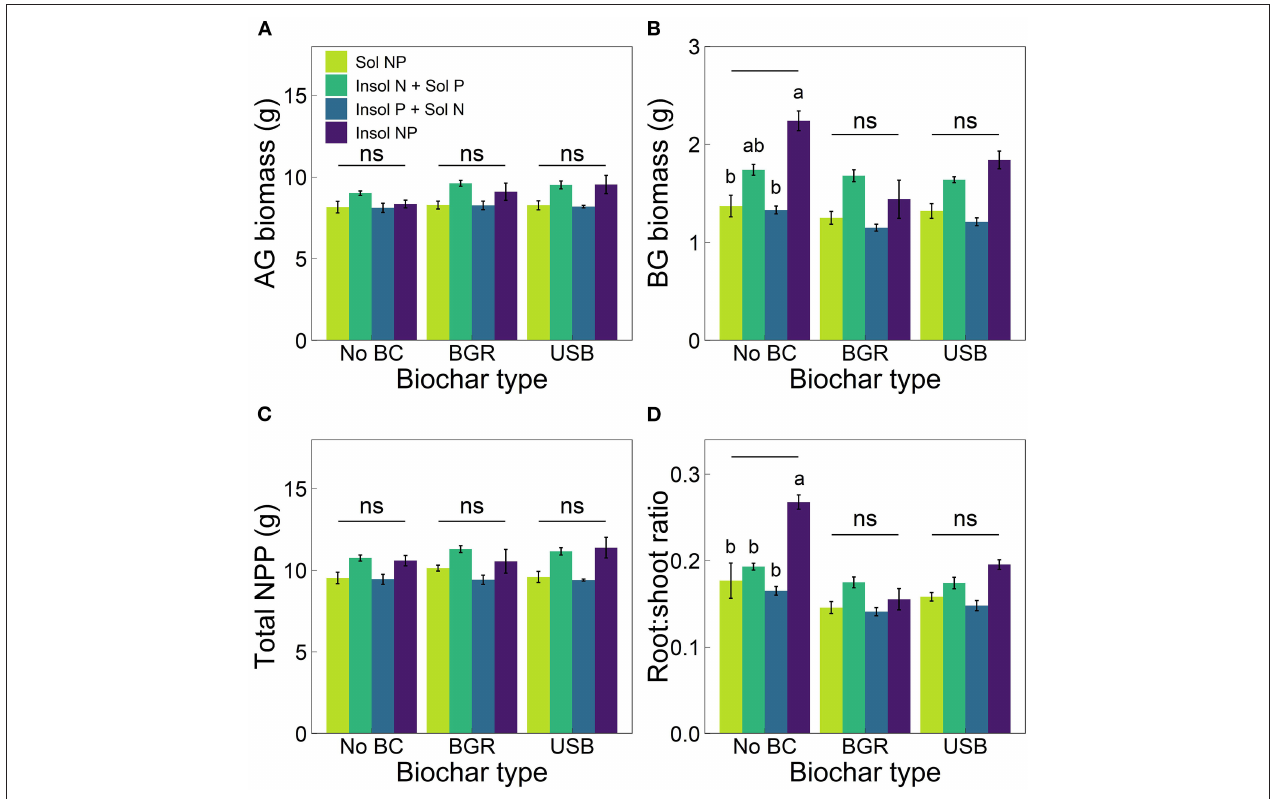
FIGURE 2 | Means ( ± SE) of (A) aboveground (AG) and (B) belowground (BG) biomass, (C) total NPP (AG + BG biomass) and (D) root:shoot ratios for biochar (x-axis) and nutrient treatments (varied colors). Lowercase letters indicate significant differences (Tukey post-hoc tests, p < 0.05) among nutrient treatments within biochar type and “ns” indicates no significant differences. Significant differences among biochar types within nutrient treatments are displayed in Supplementary Table 2 . The x-axis label “No BC” stands for No Biochar